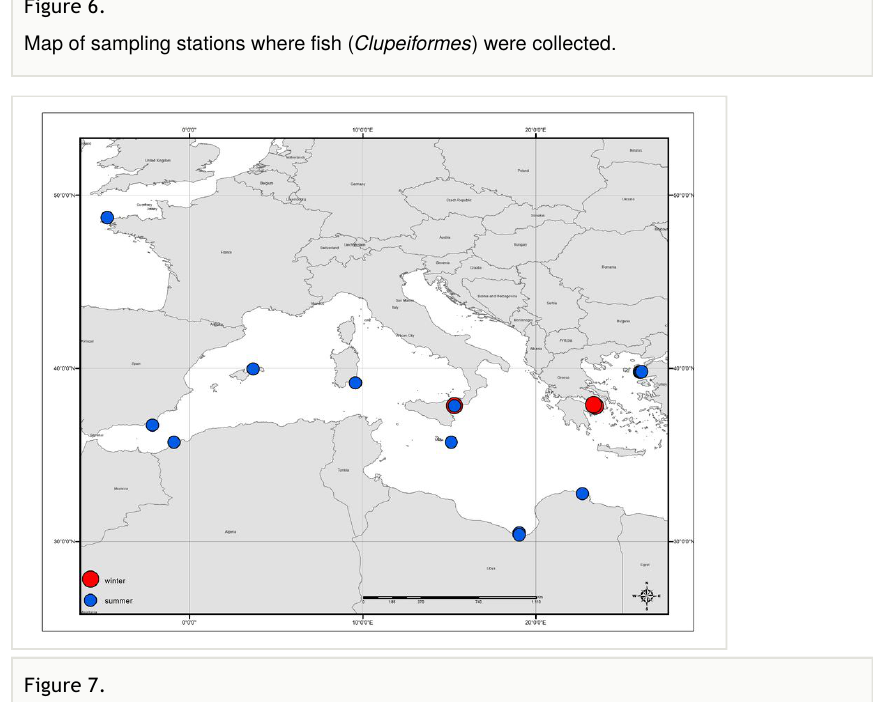
Map of sampling stations where calcareous algae (Rhodophyta) were